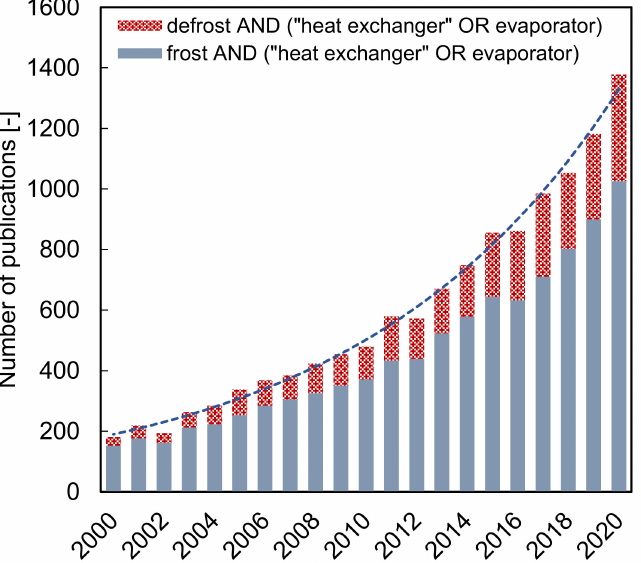
Figure 1. The number of research papers with terms related to “frost” or “defrost,” and “heat exchanger” or “evaporator” published in engineering journals for the last two decades (www. sciencedirect.com, 23 January